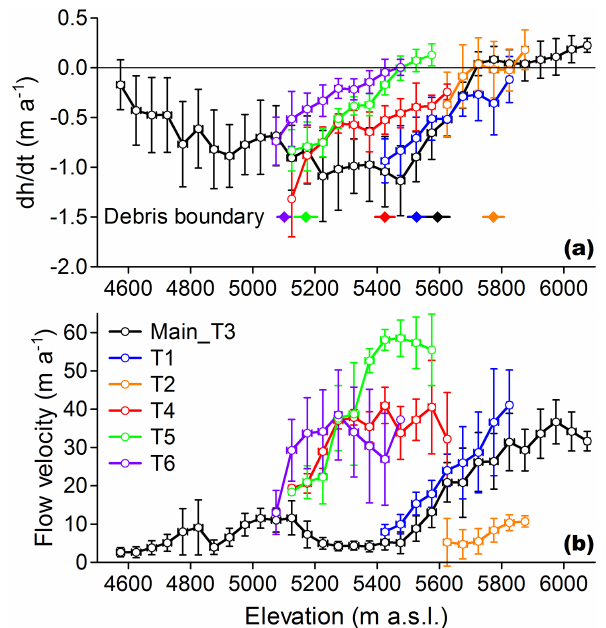
Figure 5. Elevation profiles of (a) the rate of elevation change (d h/ d t ) and (b) ice-flow velocity along the six tributaries of Kanchenjunga Glacier versus elevation. The tributaries are defined in Fig. 1. The elevation of the debris boundary of each tributary is indicated in (a) .